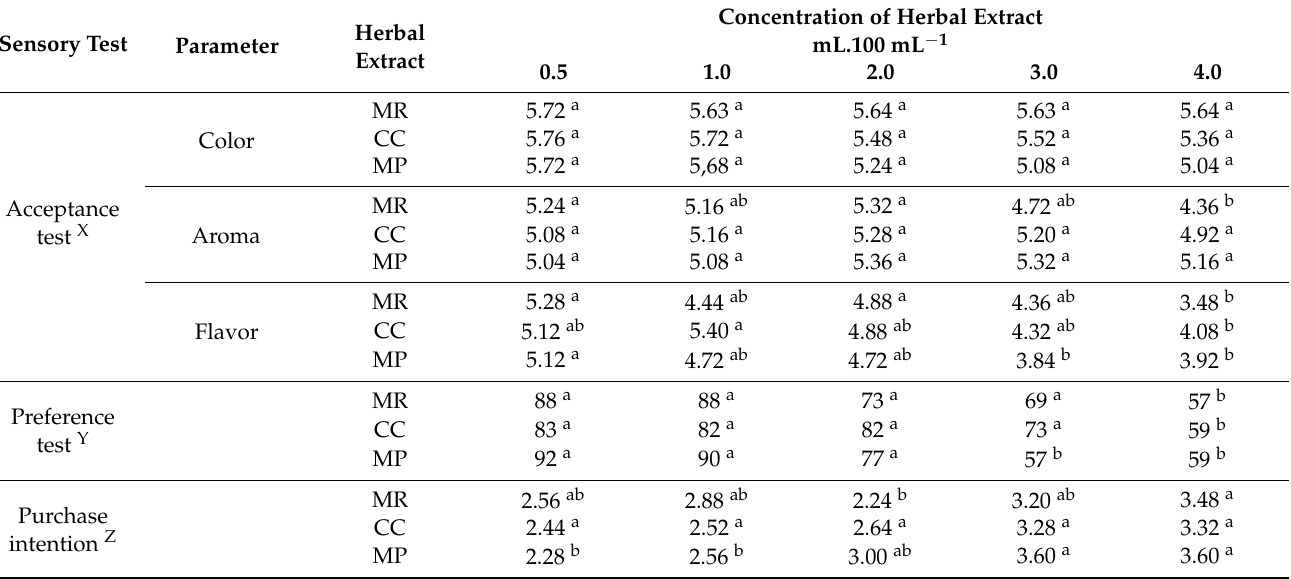
Table 1. Sensory evaluation of the functional fermented orange beverage containing increasing aromatic herbal